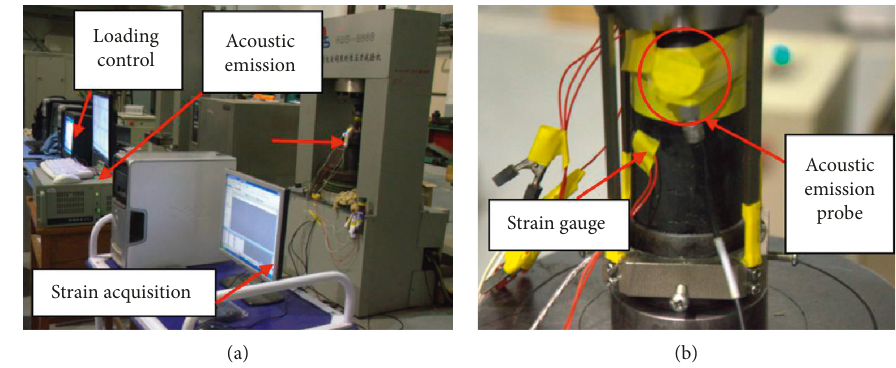
Figure 4: Testing system: (a) testing equipment; (b) monitoring system.